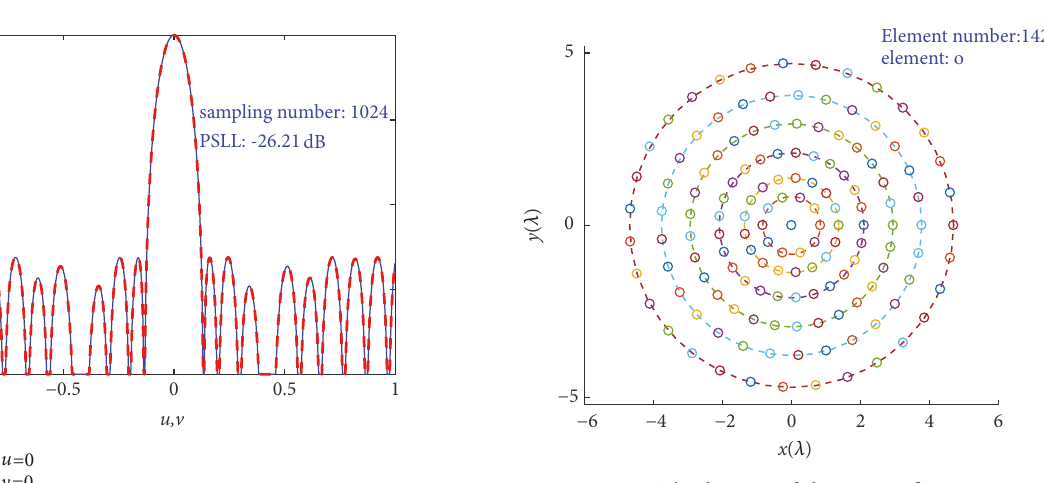
Figure 8: The diagram of element